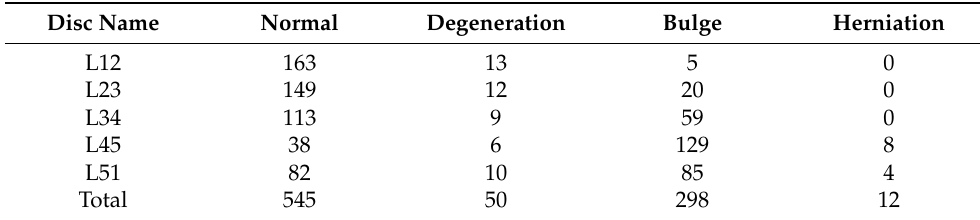
Figure 5. Number of axial T2 images for each lumbar disc. Table 5. Number of disc for each class in disc